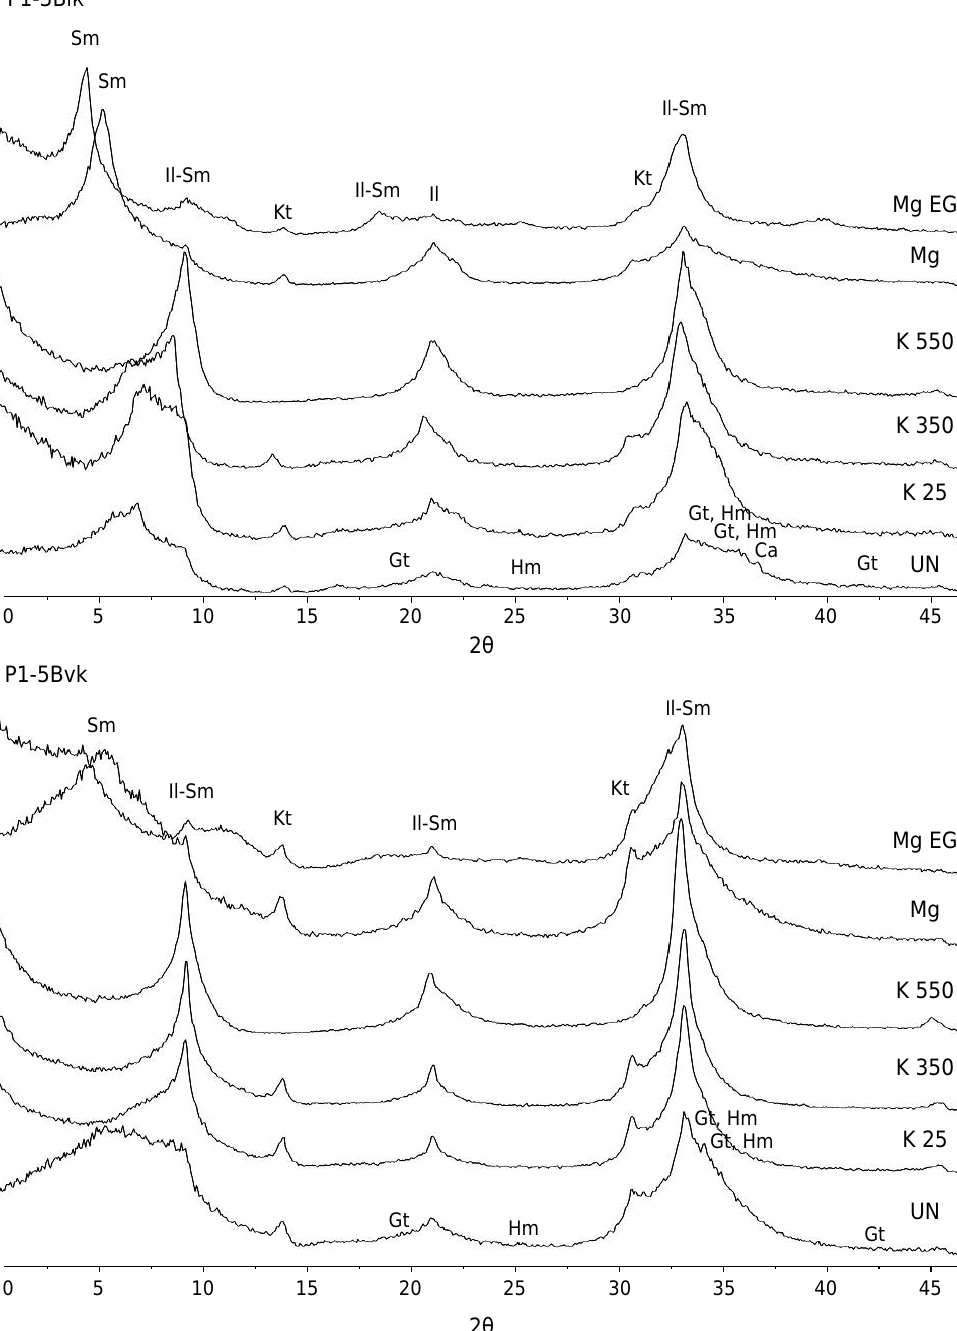
Figure 2. Diffractograms of the clay fraction of soil profile 1 (P1), 3Biќ and 5Bvk horizons. Calcite (Ca), Smectite (Sm), Illite (Il), Kaolinite (Kt), Goethite (Gt), Hematite (Hm), Untreated total sample (UN), iron-free sample saturated with magnesium (Mg) and solvated with magnesium and ethylene-glycol (MgEG), iron-free sample saturated with potassium at room temperature (K25), and after heating at 350 °C (K350)and 550 °C